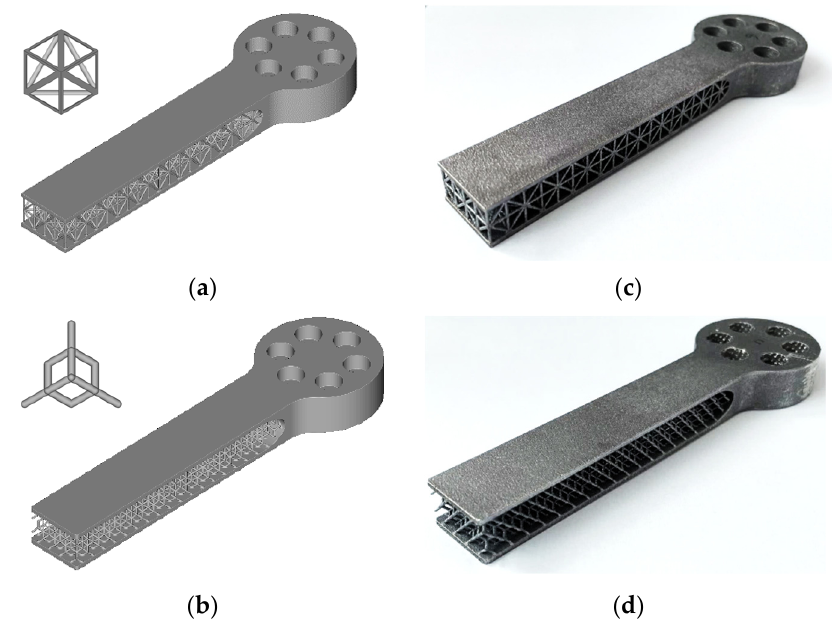
Figure 1. ( a , b ) FCC and Diamond specimen modelled with nTopology. ( c , d ) FCC and Diamond lattice specimens made by